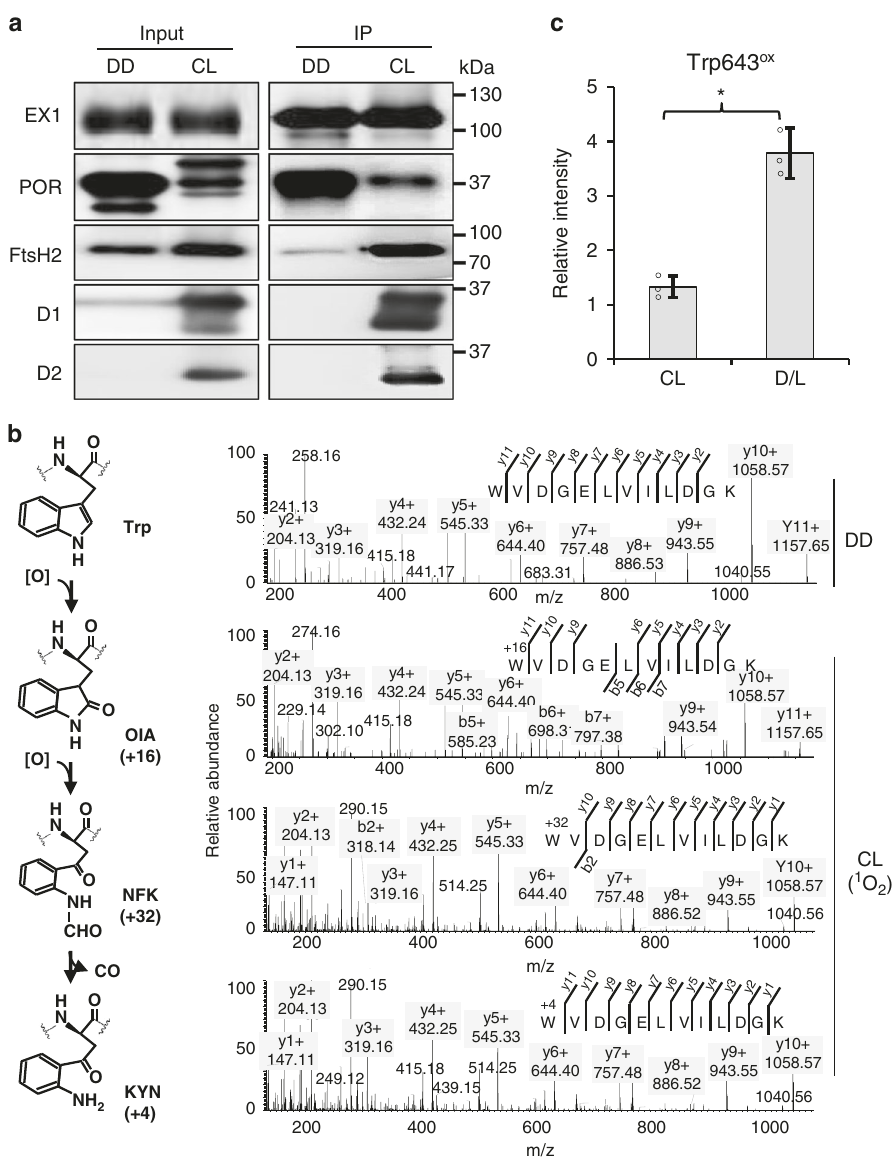
Fig. 2 Light- and 1 O 2 -dependent Trp643 oxidation occurs in vivo. a EX1-GFP protein enrichment. For input, total proteins extracted from 5-day-old dark (DD)-grown or CL-grown seedlings of EX1-GFP ex1 were analyzed. For IP, immune-reactive EX1-GFP proteins were precipitated from each input sample by adding magnetic agarose beads conjugated with GFP antibody. Trapped proteins were solubilized and separated by SDS-PAGE and probed on western blots using the indicated antibodies. b Oxidative PTM (Oxi-PTM) analysis. The IP samples were subjected to PTM analysis by mass spectrometry (MS). EX1 was found to undergo light- and 1 O 2 -dependent oxidation, especially at Trp643 in peptide 643 WVDGELVILDGK 654 . This oxidation led to the formation of oxindolylalanine (OIA), N -formylkyrnurenine (NFK), and kynurenine (KYN) with + 16, + 32, and + 4 mass shifts, respectively. c The effect of increasing levels of 1 O 2 on Trp643 oxidation. To increase the levels of 1 O 2 , 5-day-old seedlings of EX1-GFP ex1 fl u grown under CL were subjected to 2 h dark and then re-exposed to light for 5 min (D/L). The GFP-trapped EX1-GFP proteins were subjected to MS analysis and the relative levels of Trp643 oxidation was measured. Oxidation levels were calculated using the sum of absolute intensities of the peptides carrying oxidized Trp643. Bar chart represents the relative intensity of the oxidized peptides. Asterisks indicate statistically signi fi cant differences between the mean values ( P < 0.05, Student ’ s t -test)